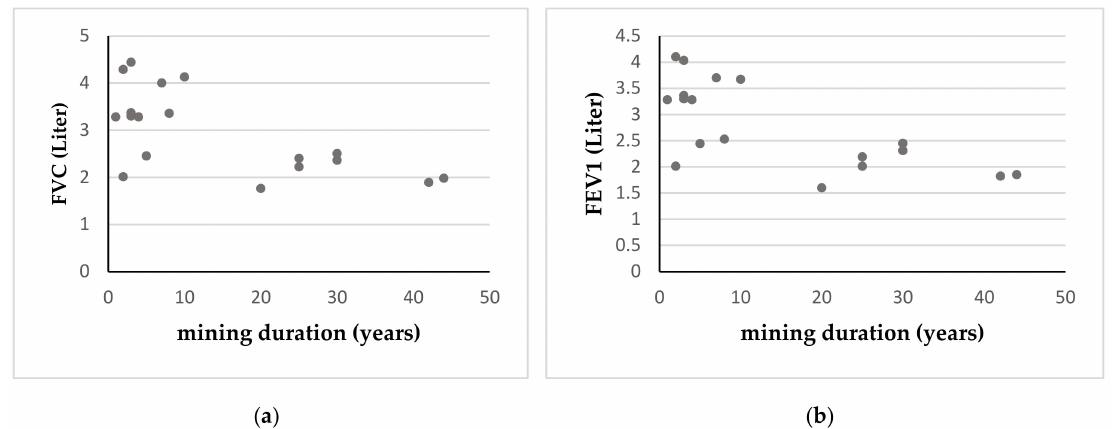
Figure 2. Correlation between the duration of mining, FVC, and FEV1 among miners. ( a ) Correlation between the duration of mining and FVC ( P = 0.001 by Spearman’s Rho correlation test); ( b ) correlation between the duration of mining and FEV1 ( P = 0.007 by Spearman’s Rho correlation